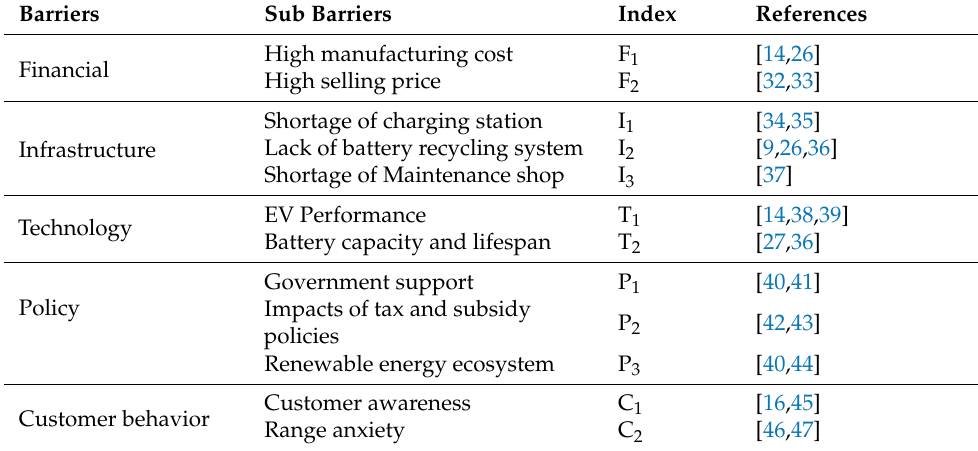
Table 2. Barriers of EV transition.